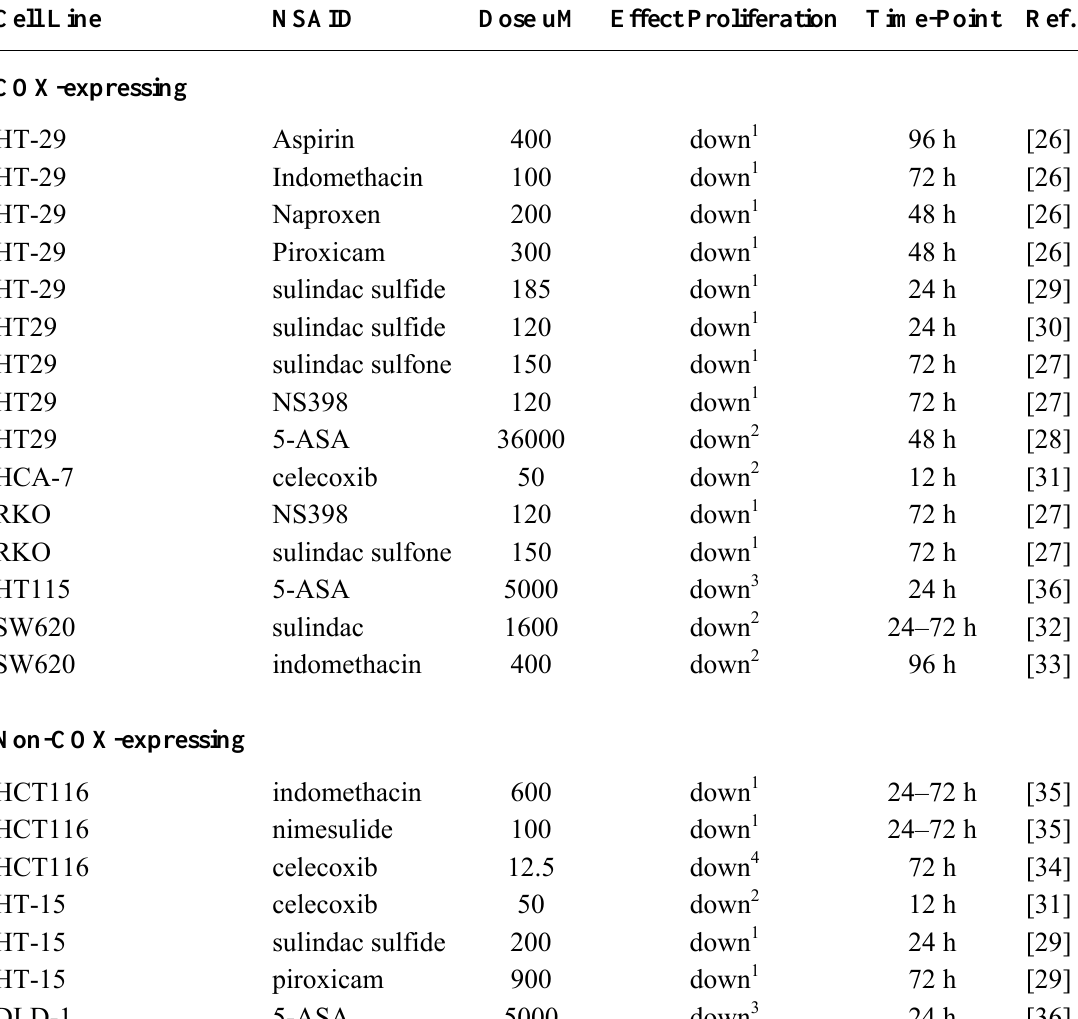
Table 1. Colon cancer cell lines and the concentration of NSAIDs used in studies that show growth inhibition. The time-point at which inhibition of cell growth is recorded is also presented. Non-COX-expressing cell lines are presented in the lower part of the table. Studies are identified according to the numerical listing given in the bibliography. 1 number of viable/attached cells, 2 MTT assay, 3 CFSE labeling, flow-cytometry, 4 growth ratio: number of treated/untreated cells. HT29, HCA7, HT115 and SW620 express COX-2; RKO express COX-1 and COX-2. 5-ASA = 5-aminosalicylic acid, CFSE = carboxyfluorescein diacetate succinimidyl ester, MTT = 3-(4,5-dimethylthiazol-2-yl)-2,5-diphenyltetrazolium bromide. NSAID Dose uM Effect Proliferation Time-Point